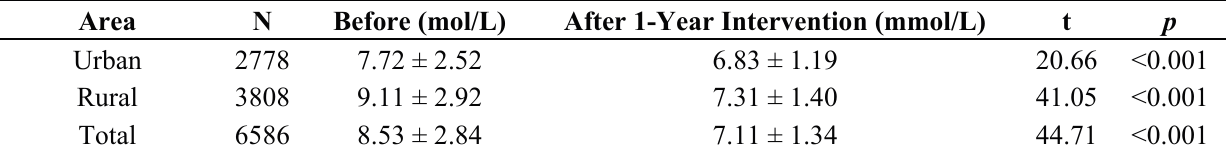
Table 5. Changes of participants’ FPG according to urbanization level (Mean ± SD).